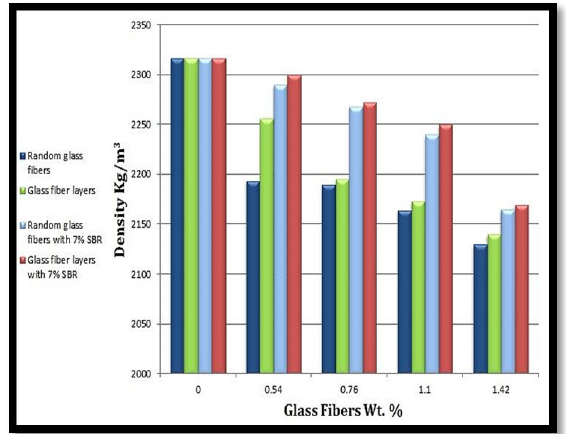
Fig. 5. Effect of layers glass fibers addition with SBR after curing for 7 and 28 days.